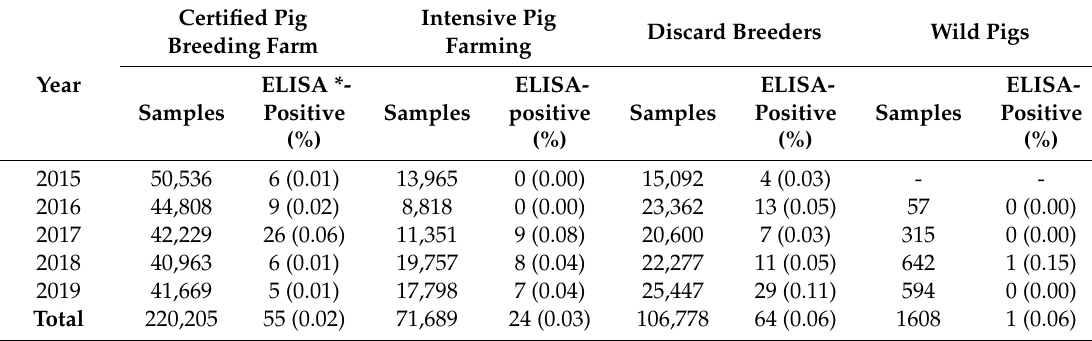
Table 4. Seroepidemiological surveys for classical swine fever carried out between 2015 and 2019, in Brazil, in the free